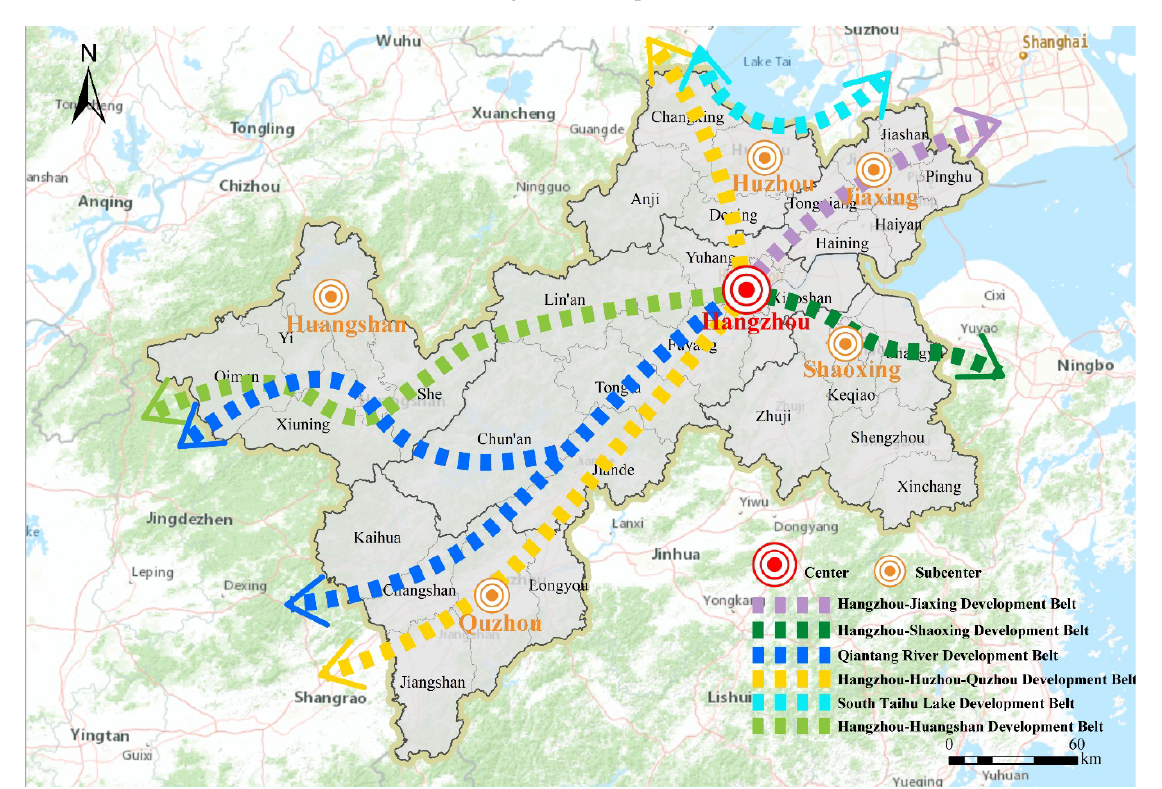
Figure 2. The schematic diagram of “Hangzhou Metropolitan Circle Development Plan (2020–2035)”.